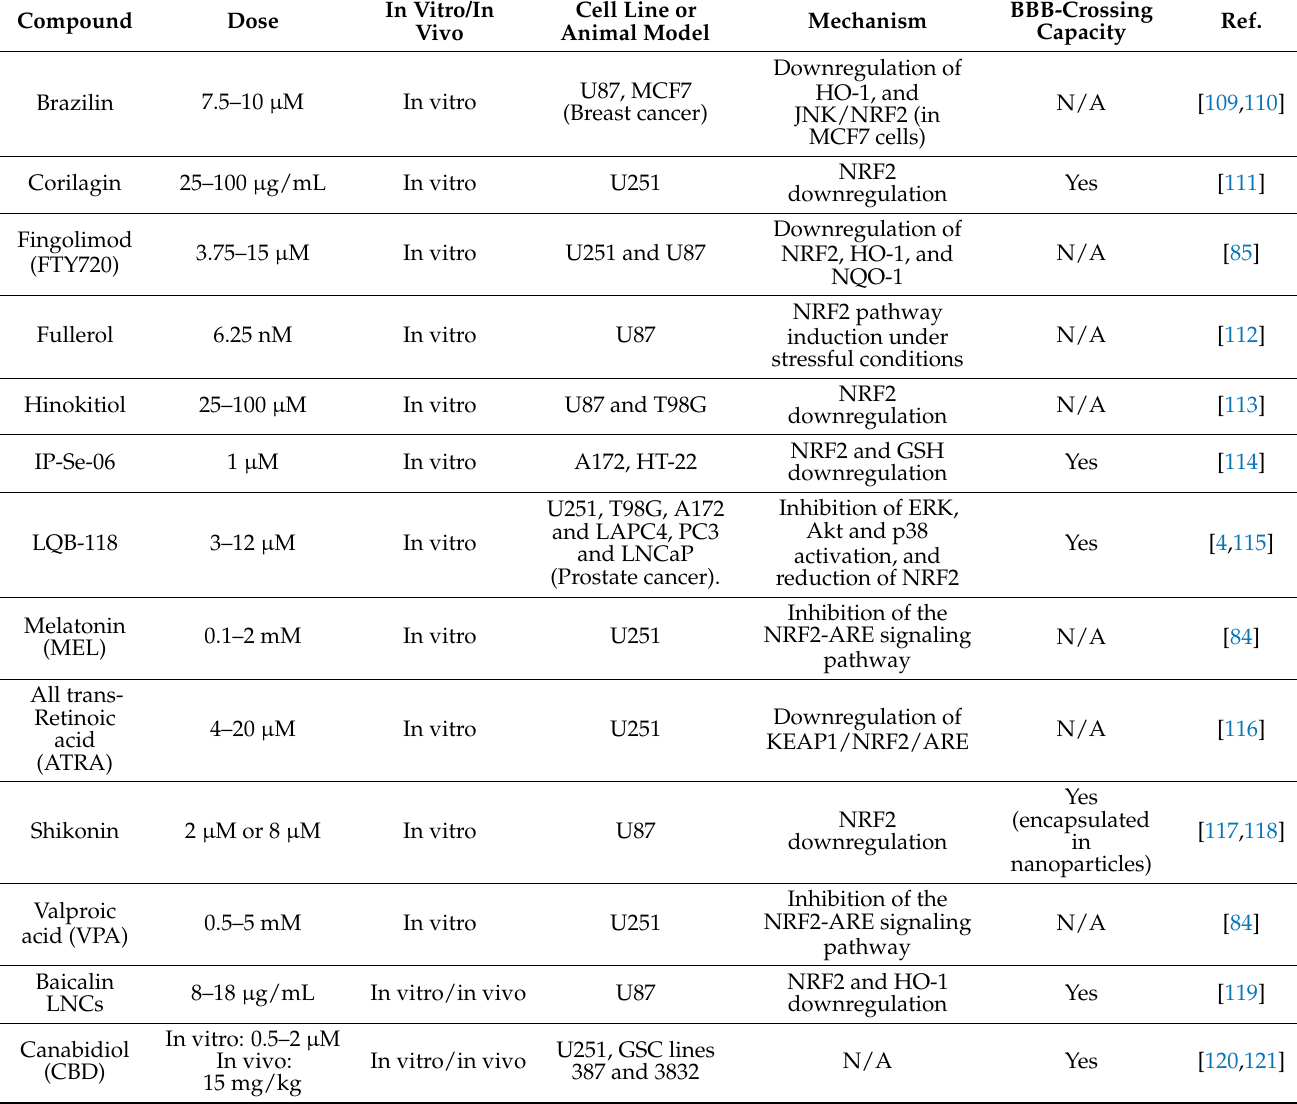
Table 1. Anti-tumor compounds that regulate NRF2 signaling in